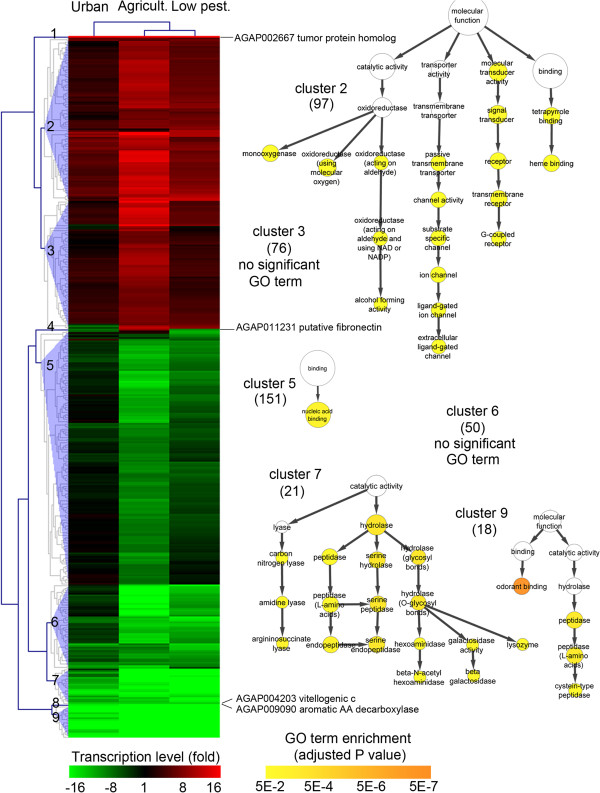
Genes differentially transcribed in any area. Clustering analysis was performed on the 416 transcripts showing a significant differential expression in any area compared to the reference strain Ifakara (P ≤ 0.001 and FC ≥ 3). Clustering of transcripts and conditions were based on differences between mean Log2 ratios in each area versus reference using Euclidean distance and complete linkage algorithm. Colour scale (green to red) indicates fold change versus reference strain. The number of transcripts represented in each cluster is shown within bracket. Gene Ontology (GO) term enrichment analyses were performed for each main cluster with all terms belonging to the category ‘molecular function’. GO terms showing an adjusted P value ≤ 0.05 were considered significantly enriched compared to all detected transcripts (hypergeometric test followed by Benjamini and Hockberg multiple testing correction). Colour scale (white to orange) indicates enrichment significance. Few non-significant GO terms are displayed for clarity.